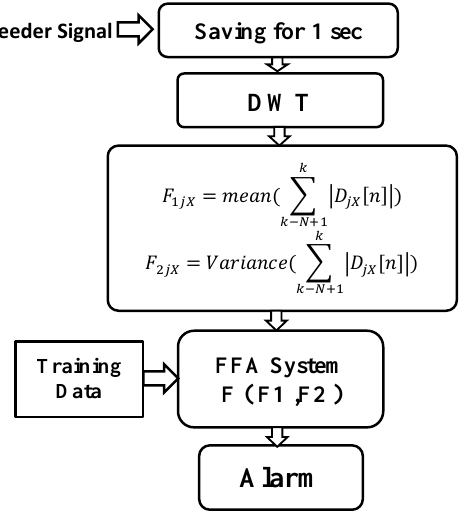
Figure 2. Process of HIF detection using DWT